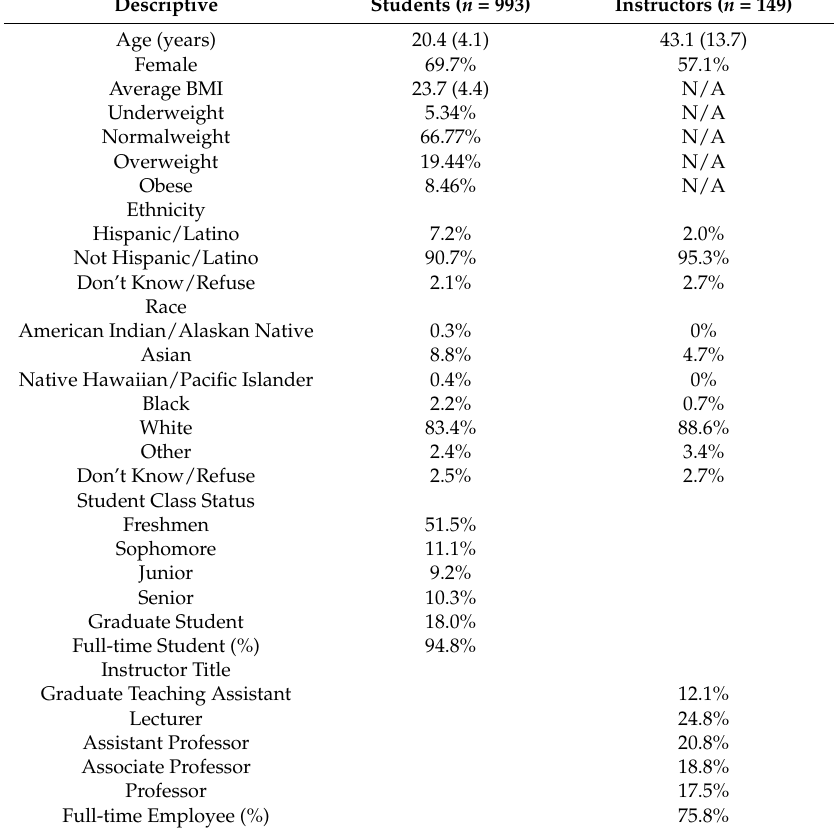
Table 1. Baseline characteristics for students and instructors expressed in means (standard deviation) or